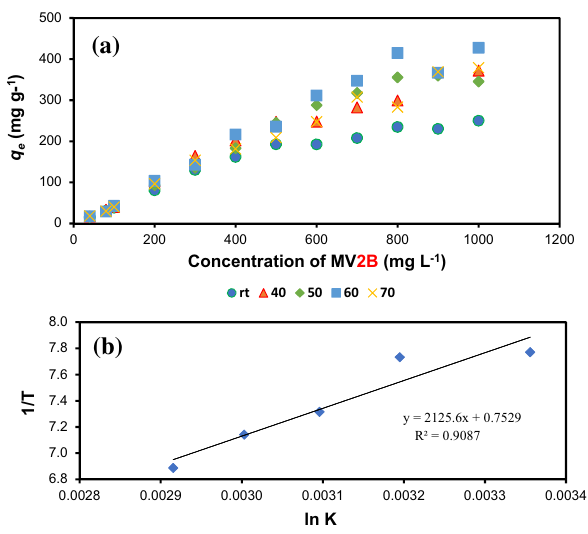
Fig. 5 ( a ) Thermodynamics data of IA at 298–343 K and ( b ) van Hoff’s